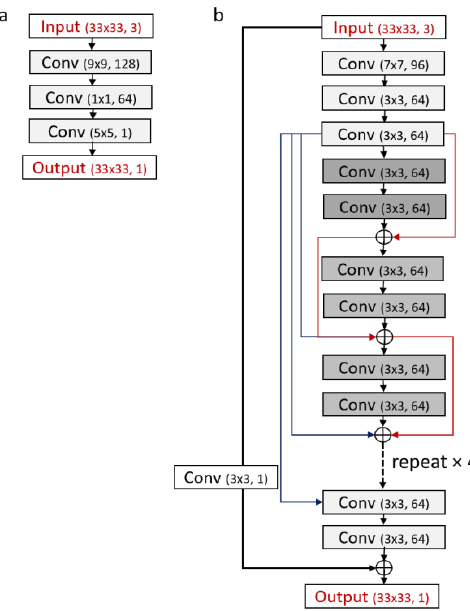
Figure 2. Configuration of the CNNs tested. ( a ) The SRCNN of Dong et al. [10]. ( b ) The deep residual and connected CNN developed. Red lines are residual blocks and blue lines are connections between residual blocks. Black line is the connection for the residual learning objective, which is put through a single convolution layer to convert the input three band image to a single band. The ⊕ symbol represents summation of the output activation layer elements.